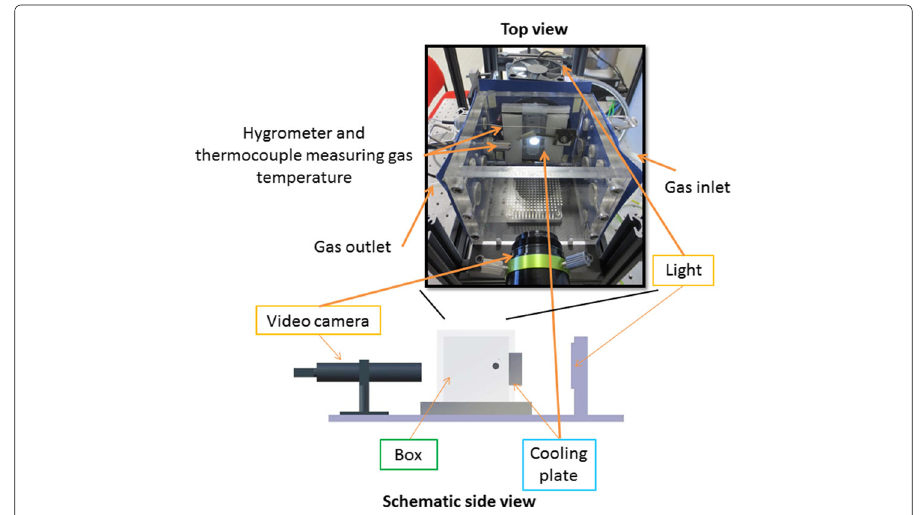
Fig. 2 Overview of the design of the experimental setup